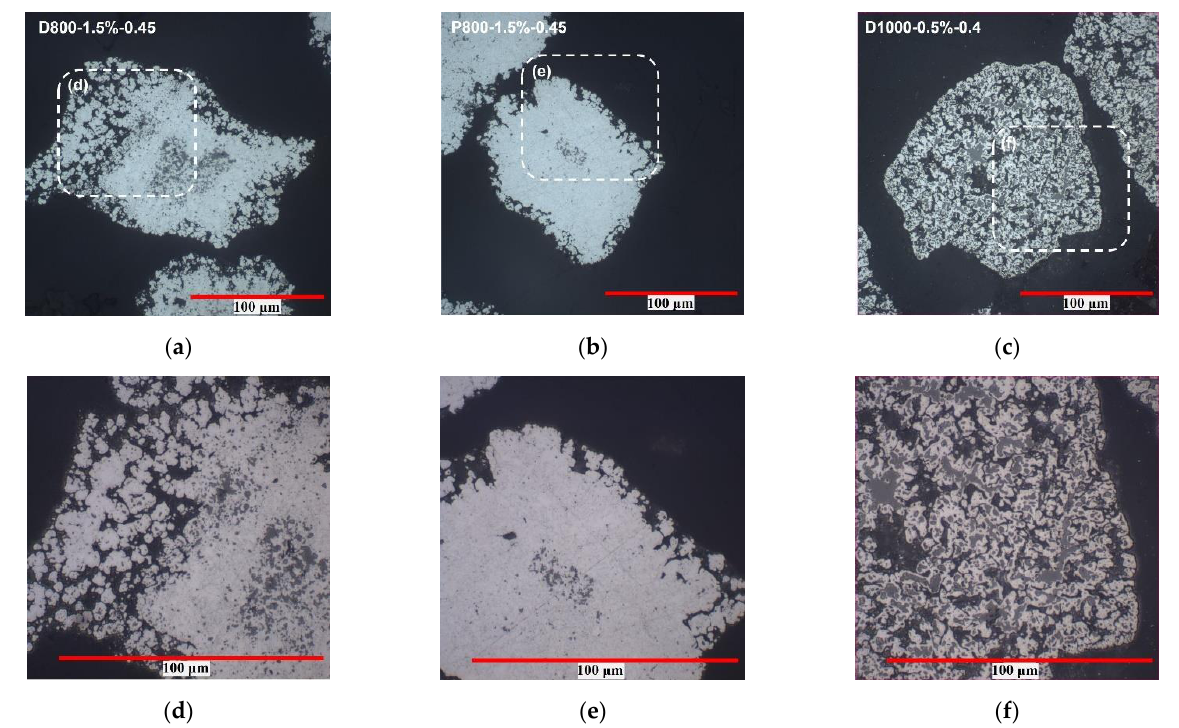
Figure 6. The polished section images of reduced iron ores: ( a , d ) Experiment No.6; ( b , e ) Experiment No.10; ( c , f ) Experiment No.2.